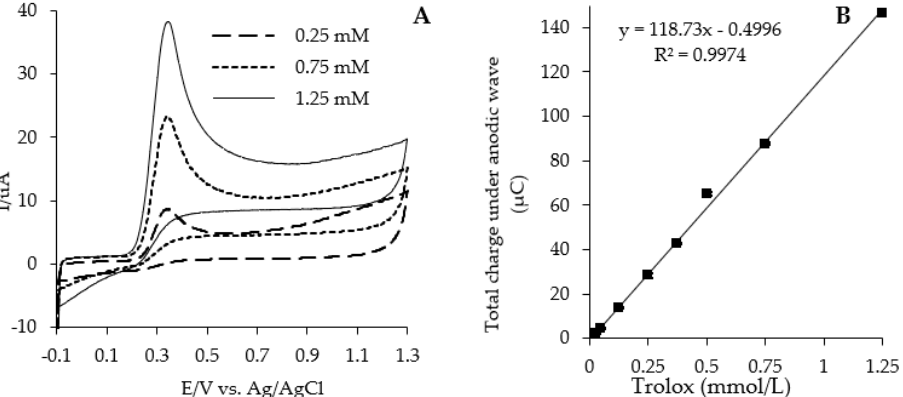
Figure 1. ( A ) Cyclic voltammograms of Trolox concentration (0.25–1.25 mM) in aqueous methanol (1:4, v/v ) and 0.1 M sodium acetate–acetic buffer (pH 4.5); scan rate 100 mV ∙ s − 1 . ( B ) The dependency